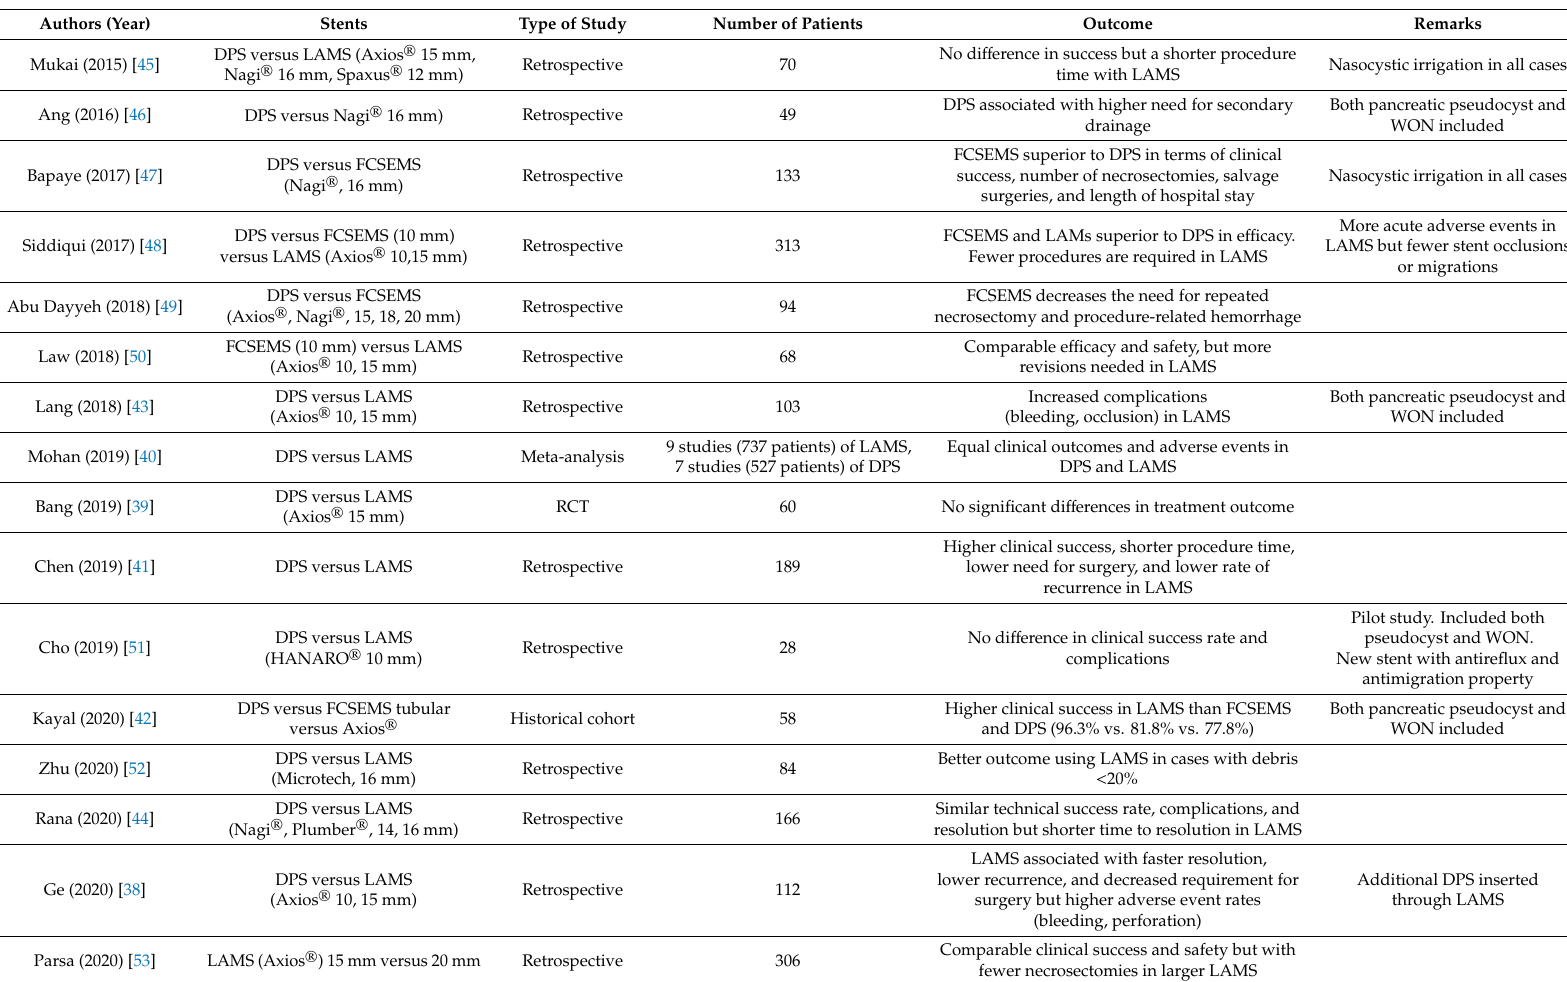
Table 2. Comparative studies of each type of stents for the treatment of walled-o ff pancreatic necrosis